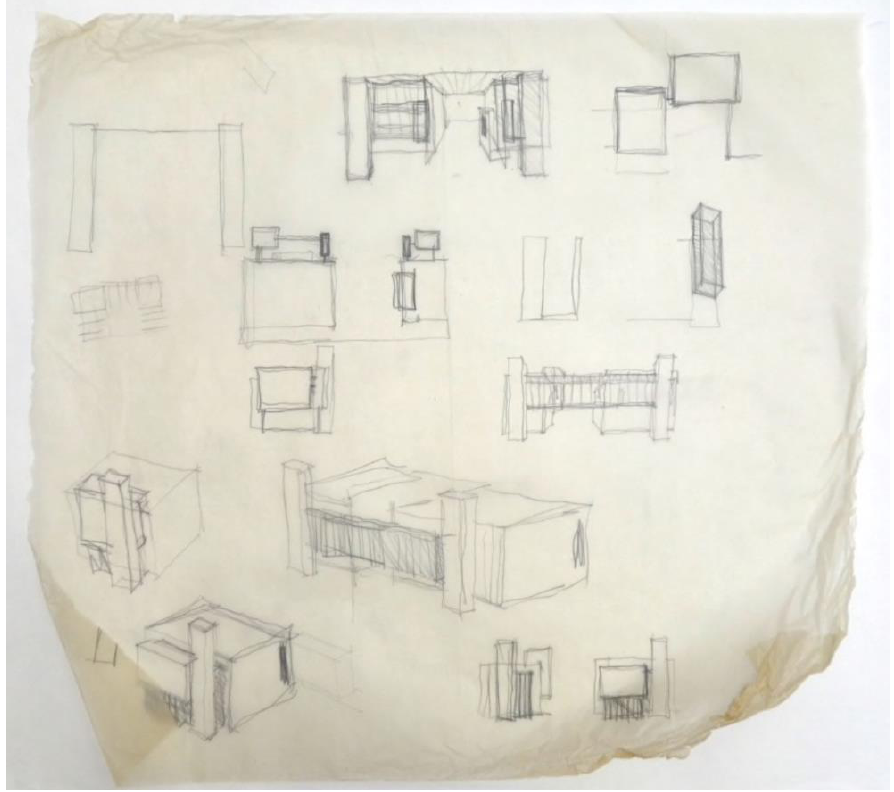
Figure 2. Frank Gehry, Danziger Studio and Residence, Los Angeles, 1964–1965. © Frank O. Gehry. Frank Gehry papers, Series I: Architectural Projects, Getty Research Institute, Los Angeles, CA. Digital image courtesy of the Getty Research Institute Digital Collections.